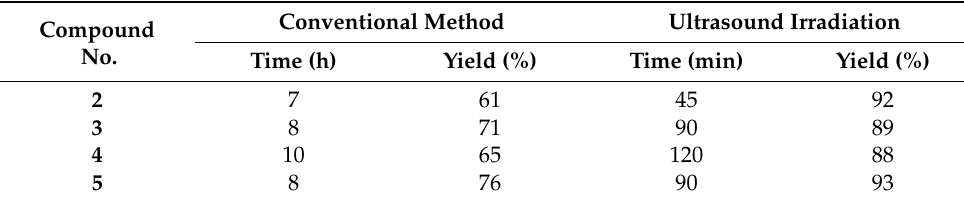
Table 1. Comparative study toward the synthesis of sugar hydrazones 2 – 5